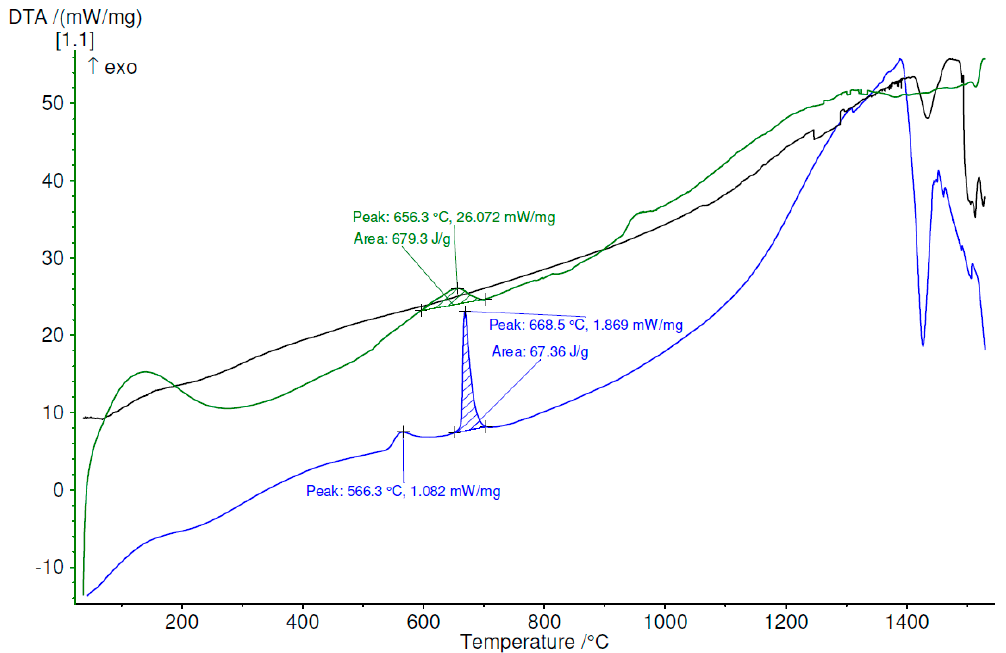
Figure 18. DTA variation as a function of temperature, up to 1530 °C, for Ti 56 Zr 10 Si 15 Nb 19 alloy, bulk (black) and melt-spun ribbons (green—MS1, blue—MS2).